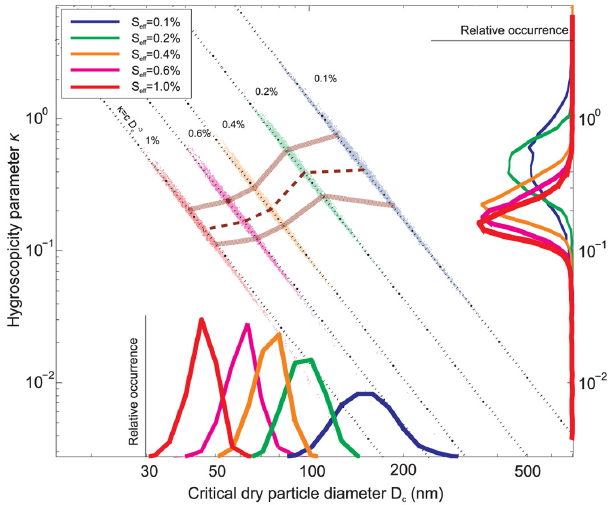
Fig. 7. Distributions of κ values as a function of dry particle di- ameter. The different colours indicate different S eff levels, and the sides of the figure show relative occurrence of κ (vertical axis) and D c (horizontal axis) calculated with log-equal bins. The dashed and the adjacent lines show the 25th, 50th and 75th percentiles of κ for each S eff level. The gray dotted lines show the expected κ ∼ D − 3 c relationship for each S eff